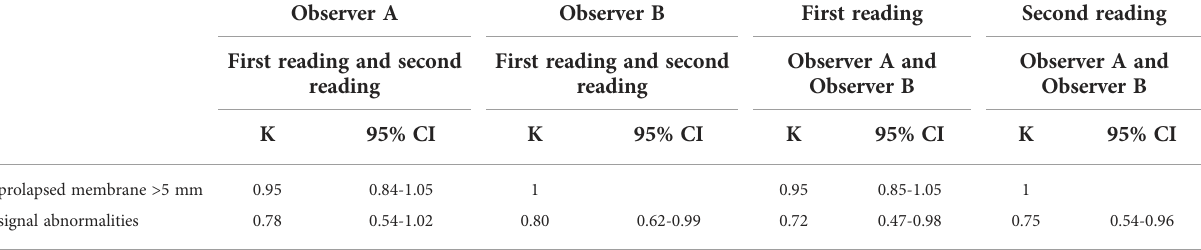
TABLE 2 Inter- and intra-observers agreement by Kappa